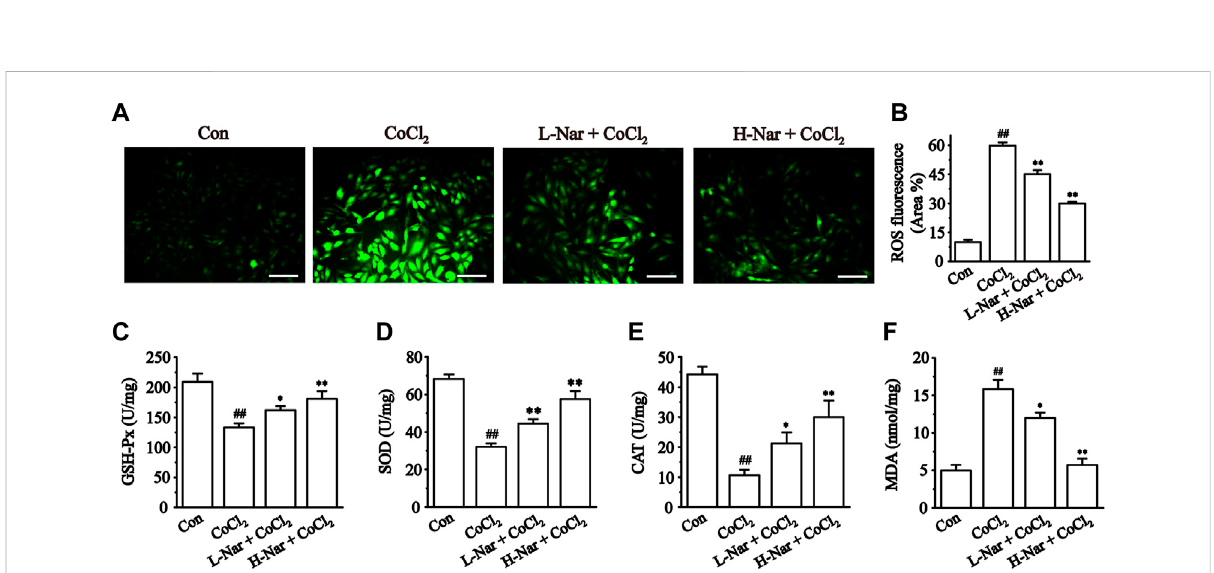
FIGURE 5 Effects of Nar on CoCl 2 -induced the levels of ROS, and the effects of Nar on the levels of oxidative stress in H9c2 cells. (A) Morphological changes of intracellular ROS (scale bar: 100 μ m; magni fi cation: ×200). (B) Statistical analysis of ROS fl uorescence. (C) GSH-Px activity. (D) SOD activity. (E) CAT level and (F) MDA level. Data were expressed as the mean ± SEM of each group. ## p < 0.01 vs. Con group; * p < 0.05, ** p < 0.01 vs.